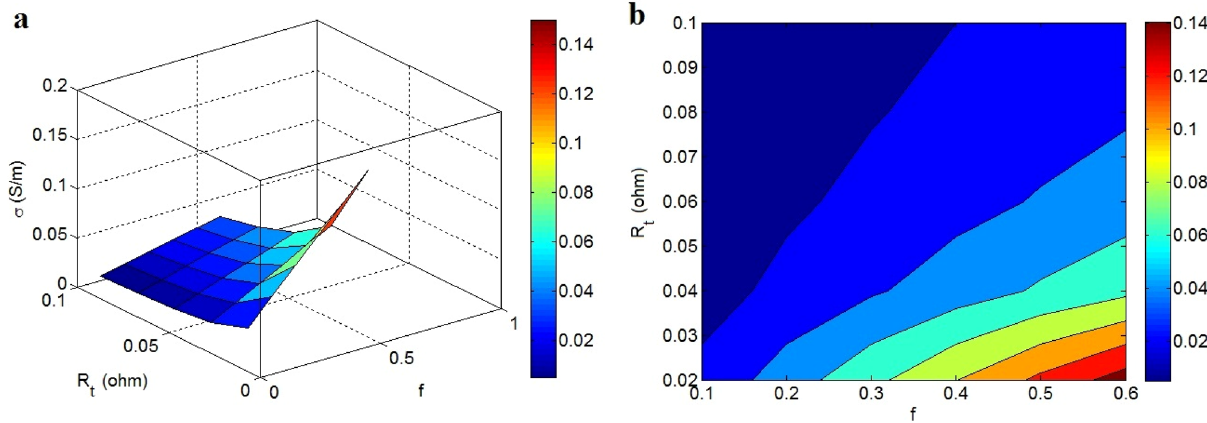
Figure 10. Dependences of efficient conductivity on “f” and “R t ” by ( a ) 3D and ( b ) contour